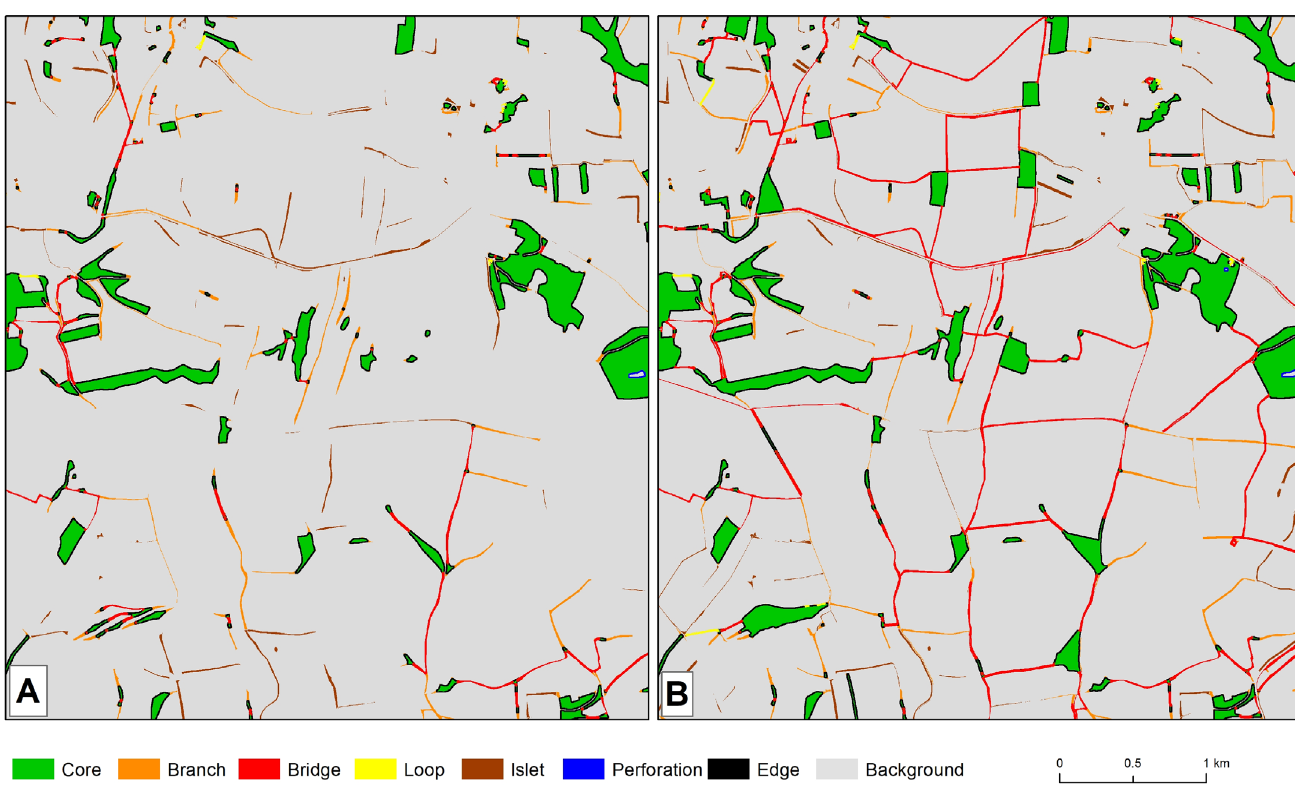
Figure 6: Subset of the resulting Morphological Spatial Pattern Analysis (MSPA) of green infrastructure (GI) without adding elements of Territorial System of Ecological Stability (A) and with added elements (B) in the Kyjovsko